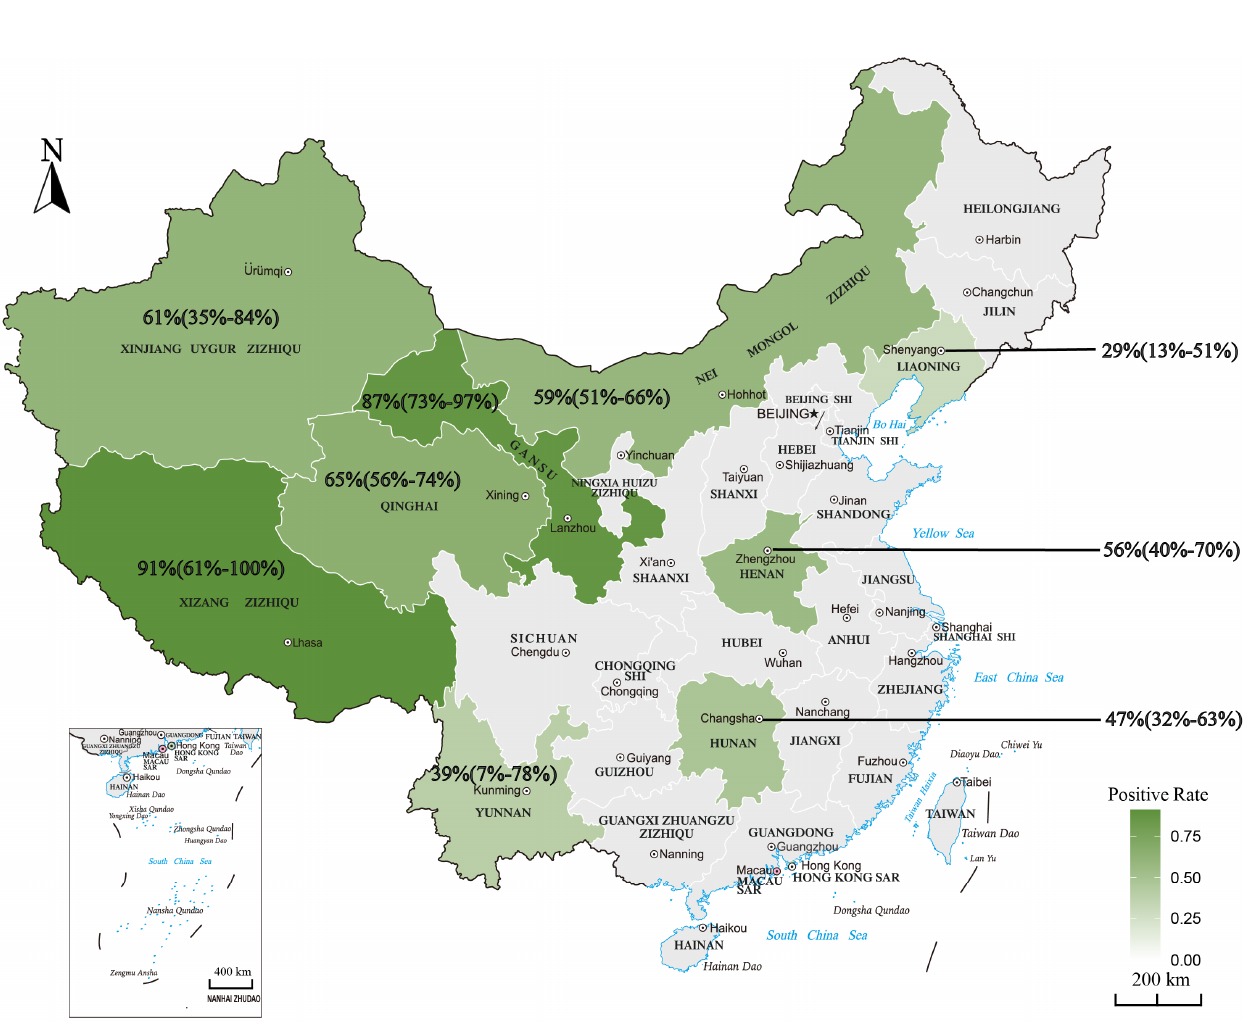
Figure 3. Prevalence of Sarcocystis infection among ruminants in mainland China.